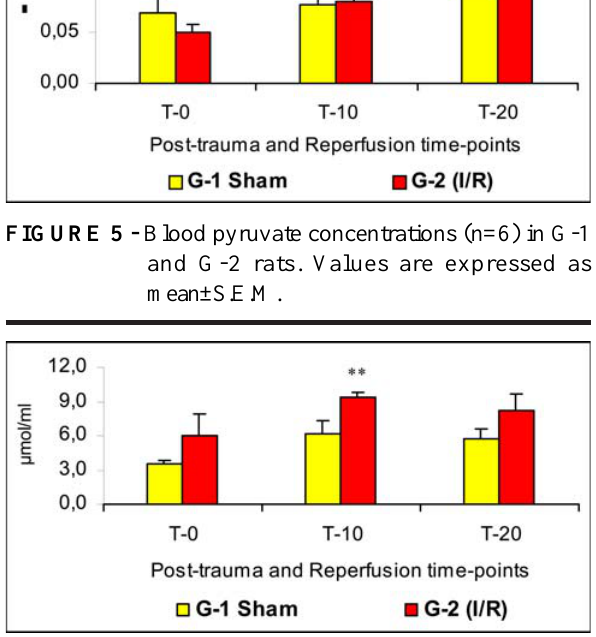
FIGURE 6 - Blood glucose concentrations (n=6) in G-1 and G-2 rats. Values are expressed as mean±S.E.M.